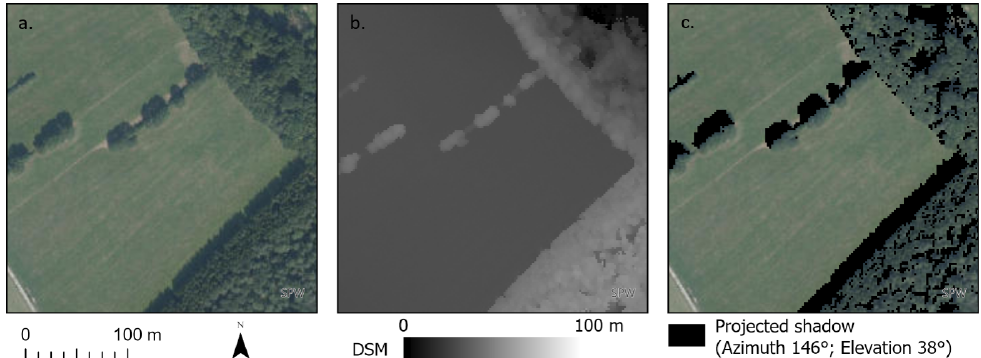
Figure 4. ( a ) Orthophoto (SPW) with tree shadows in a grassland, ( b ) digital surface model (DSM, credits SPW) showing the elevation of the top of objects above the ellipsoid, and ( c ) projected shadows based on the DSM with given sun